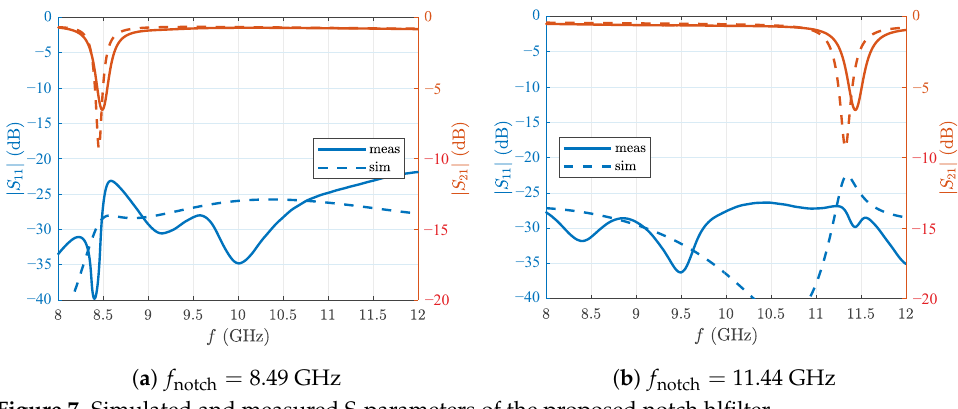
Figure 7. Simulated and measured S-parameters of the proposed notch